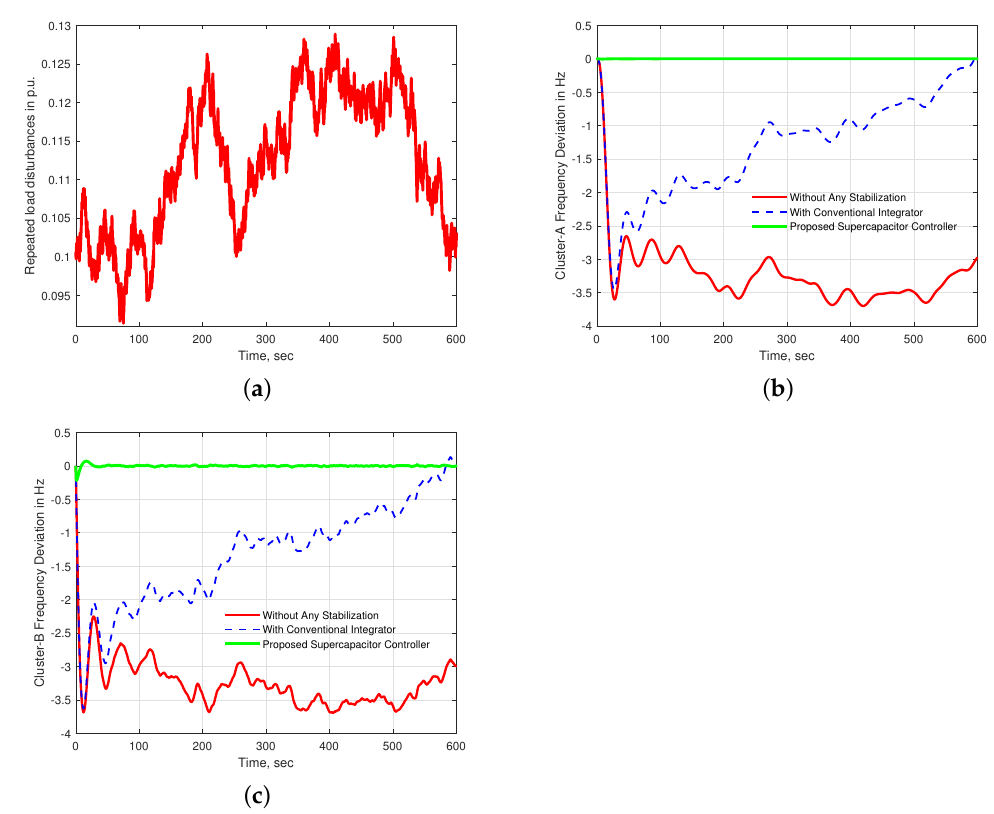
Figure 18. ( a ) Renewable energy fluctuation; ( b ) frequency oscillation in cluster A; ( c ) frequency oscillation in cluster